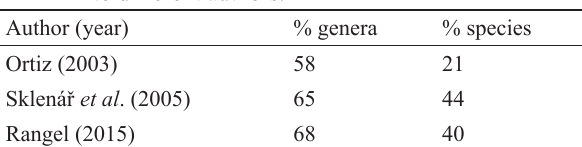
Table 3. Percentage of flora in the catalogue (264 gener and 666 species) compared to the data on genera and species in the Ecuadorian páramos according to different